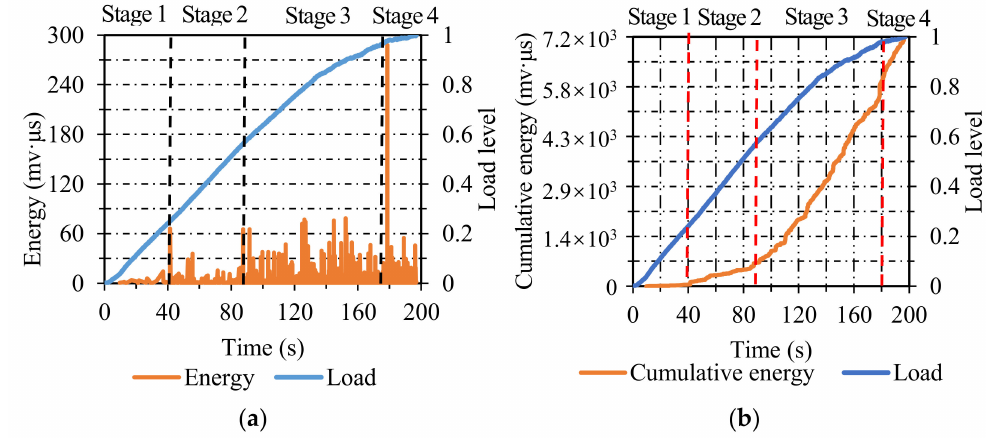
Figure 4. The energy and cumulative energy distribution of AC: ( a ) energy; ( b ) cumulative energy.